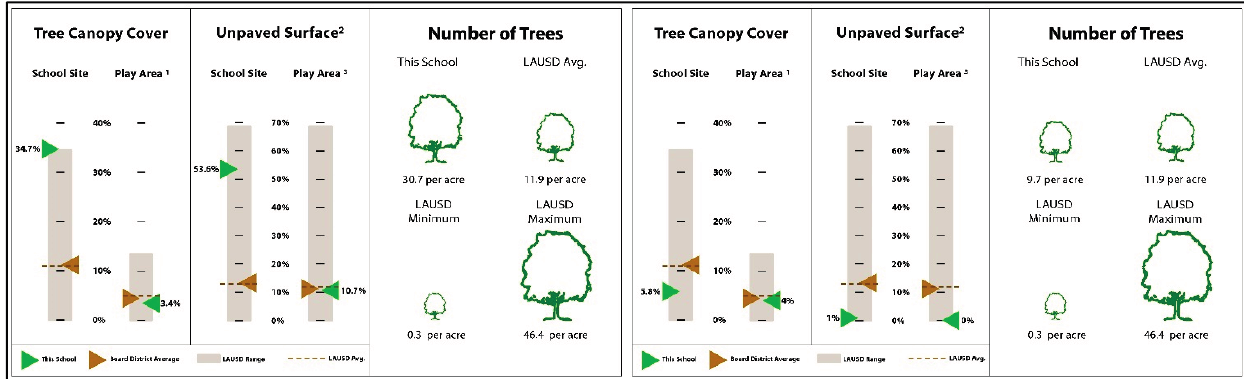
Figure 3. Example Infographic representation of the